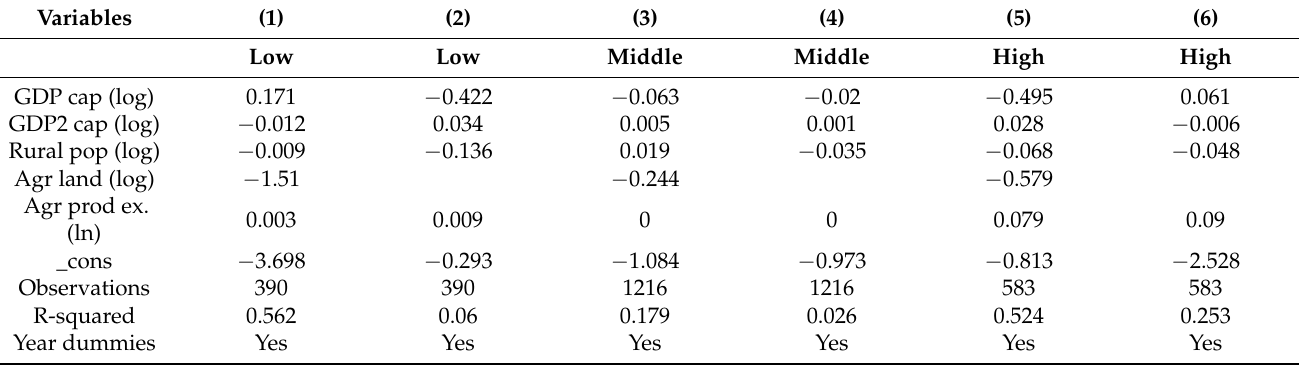
Table A6. Long run, income clusters, net agricultural exports and net exports of forests products as additional control variables.